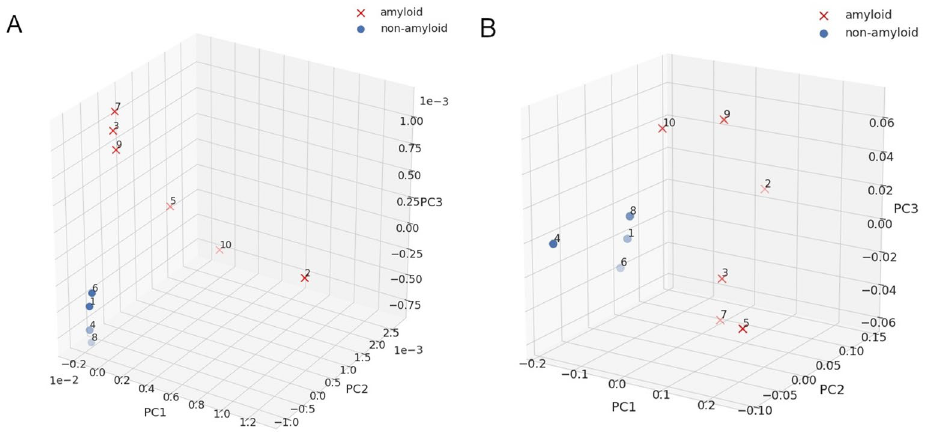
Figure 4. PCA plots for IR spectra of the reference set : ( A ) ATR-FTIR. ( B ) IR microscopy. Crosses denote amyloids and dots represent non-amyloids, as identified on the spectra by a human expert.